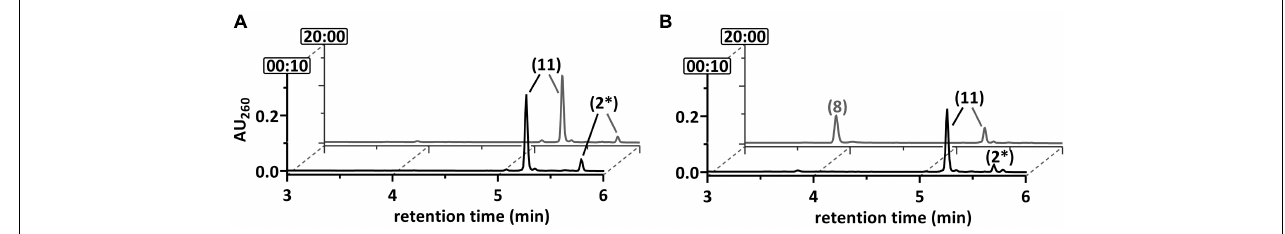
FIGURE 5 | Ultraperformance liquid chromatography diagrams demonstrating the time-dependent conversion of 2-F-6-OH-1-enoyl-CoA. The diagrams show the time-dependent conversion by (A) DCH or (B) DCH+OAH. UPLC analyses of samples are shown, that were taken at representative time points as indicated by the numbers (min) at the y -axis. The peak numbers refer to those assigned to structures in Figures 1 , 7 : 6-F-1,5-dienoyl-CoA (2 ∗ ), 3-OH-pimeloyl-CoA (8), 2-F-6-OH-monoenoyl-CoA (11).